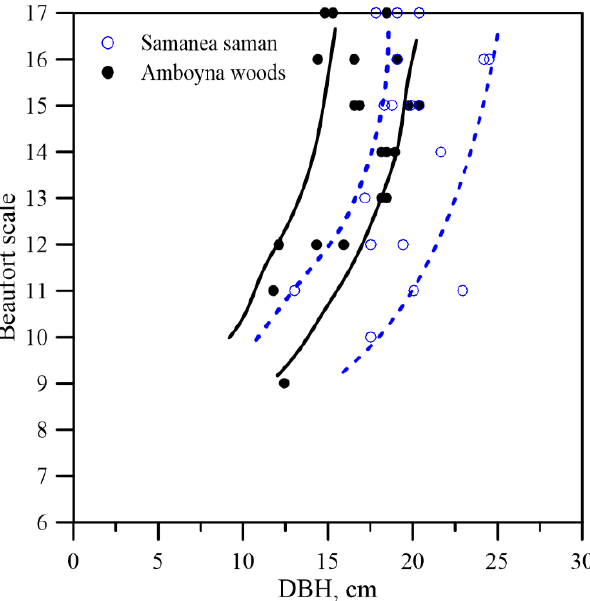
Figure 9. Relationship between the Beaufort scale and the DBH scale for samanea saman and amboyna wood.